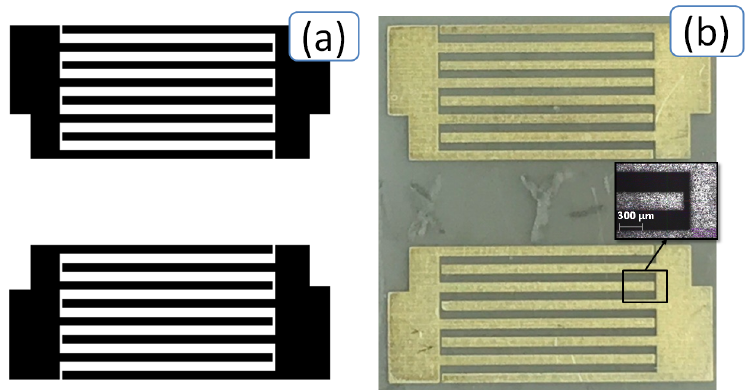
Figure 3. Sketch of the printed layout ( a ) and photo ( b ) of the produced delay line on YX LiNbO 3 plate.